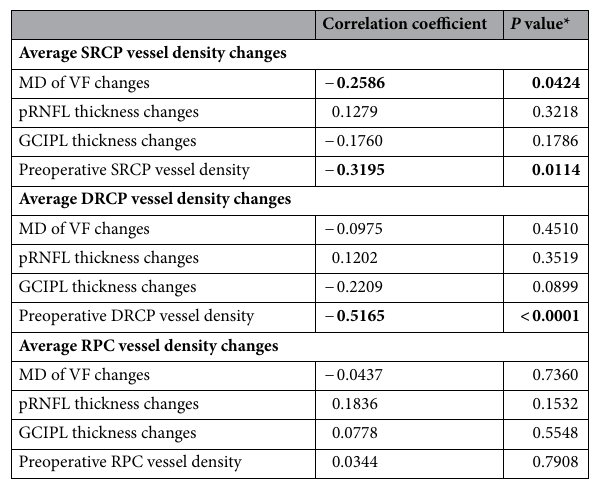
Table 3. Association analysis between vessel density changes and preoperative vessel density and structural and functional changes. Significant values are indicated in bold. MD mean deviation, VF visual field, pRNFL peripapillary retinal nerve fiber layer, GCIPL ganglion cell-inner plexiform layer, SRCP superficial retinal capillary plexus, RPC radial peripapillary capillary. * P values by Spearman’s